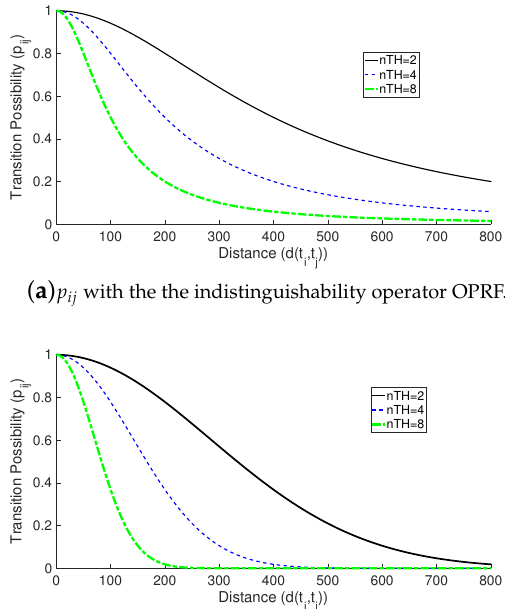
Figure 1. Environments with 100 tasks used for the experiments. Blue dots represent the position of the tasks or objects.